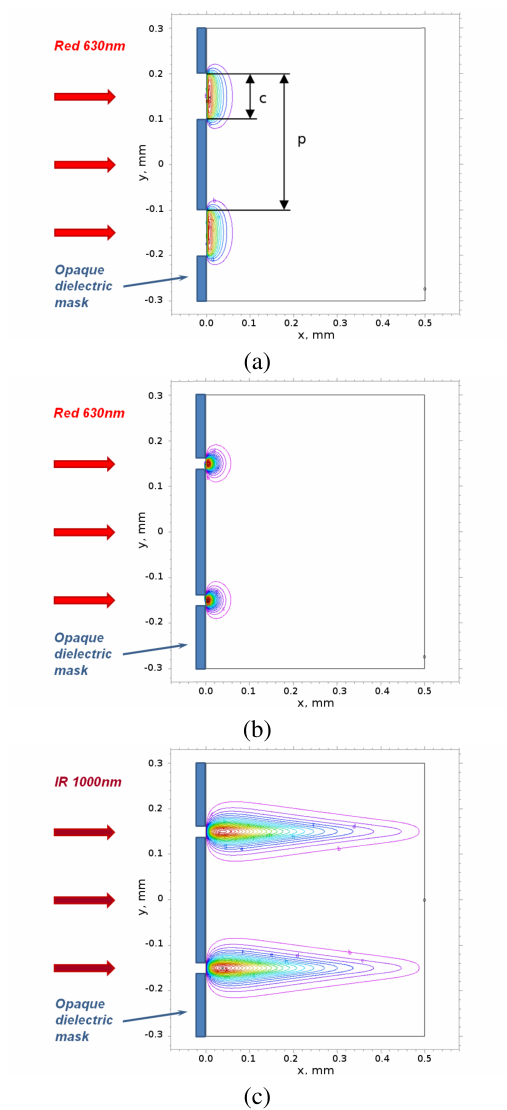
Figure 1: Photoconductive gratings of (a) strip-like, (b) wire-like, and (c) fin-like profile in a 0 . 5 mm Si wafer excited by (a, b) red light (630 nm) and (c) IR radiation (1000 nm) at the recombination length L = 0 . 02 mm, the grating period p = 0 . 3 mm, and the air slots in the grating mask (a) c = 0 . 1 mm and (b, c) c = 0 . 02 mm (curves show the conductivity